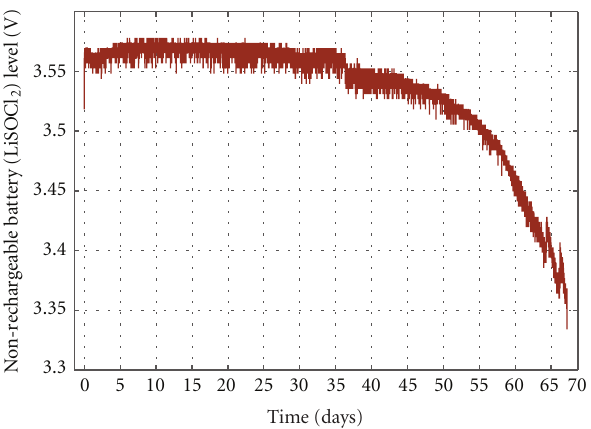
Figure 3: Battery level discharging profile. Experiment with a typi- cal WSN node taking measurements and sending data every minute (17dBm TX pwr